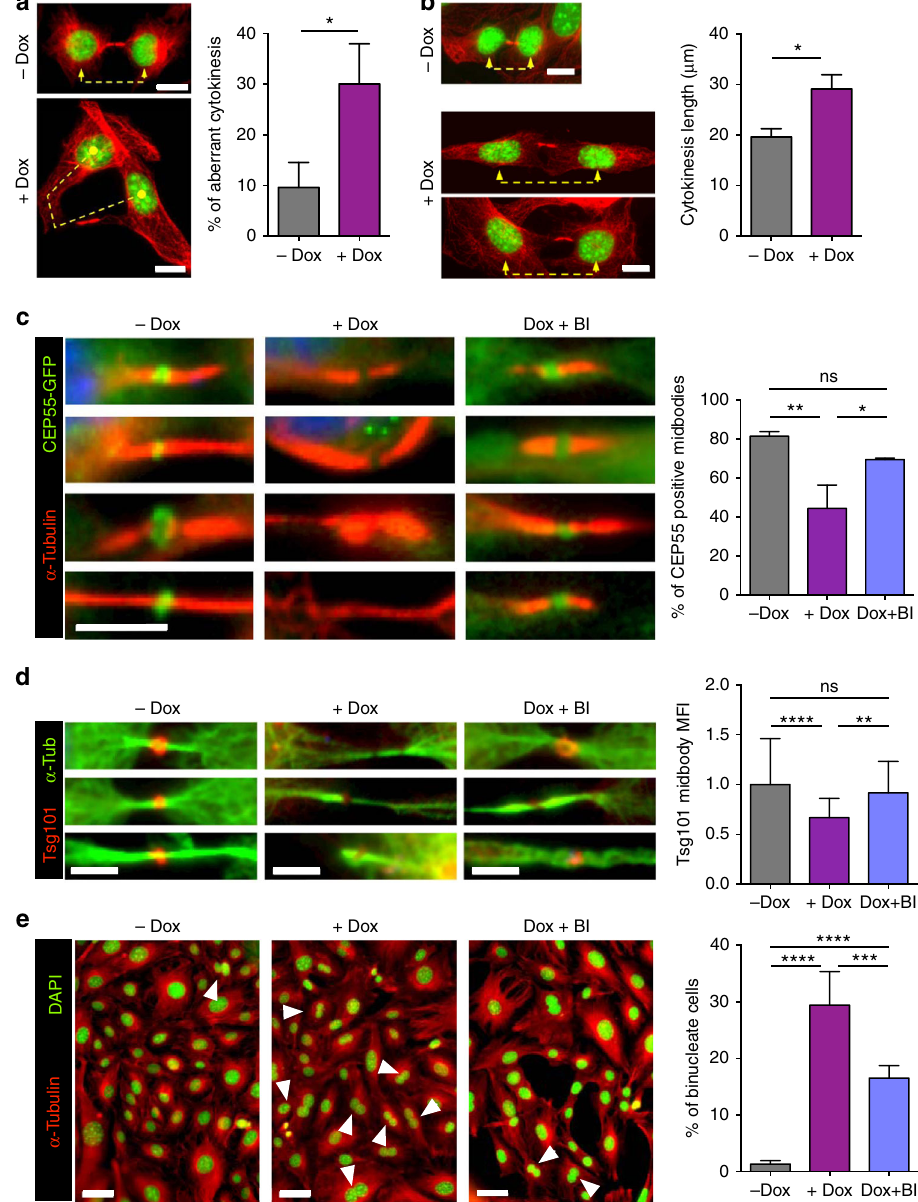
Fig. 5 Overexpression of Plk1 impairs Cep55 and ESCRT loading into the cytokinesis midbody. a ( + /Plk1);(rtTA/rtTA) MEFs were untreated ( – Dox) or treated for 24 h with doxycycline ( + Dox), fi xed and stained for α -tubulin (red) and DAPI (DNA, green). Cells in cytokinesis ( n > 100 per condition; n = 3 replicates) were evaluated for aberrant cytokinesis, considering the midbody formation and shape, and correct distribution of DNA into the two daughter cells. Scale bars, 10 μ m. b The length of the cytokinesis bridge was evaluated by measuring the distance in between the two daughter nuclei in MEFs untreated or after 24 h of Dox treatment ( – Dox, n = 17 cells; + Dox, 23 cells). Scale bars, 10 μ m. In a , b *, p < 0.05; Student ’ s t -test. c MEFs expressing a CEP55-EGFP fusion (green) were treated for 24 h with Dox ( + Dox), in the absence or presence of 1 μ M of the Plk1 inhibitor BI2536 for 1 h at the end of the Dox time (Dox + BI), or left untreated as control ( – Dox). α -tubulin is in red. Data represent the percentage of cells with positive CEP55-EGFP signal at the midbody ( – Dox, n = 134; + Dox, n = 94; Dox + BI, n = 47 cells; n = 3 replicates ( – Dox, + Dox) or 2 replicates (Dox + BI)). Scale bar, 5 μ m. d MEFs expressing a Tsg101-mCherry fusion (red) were treated for 24 h with Dox ( + Dox), in the absence or presence of 1 μ M of BI2536 for 1 h at the end of the Dox time (Dox + BI), or left untreated as control ( – Dox). α -tubulin is in green. Data represent Tsg101-mCherry mean intensity at the midbody ( – Dox, n = 81; + Dox, n = 60; Dox + BI, n = 37 cells; n = 2 replicates). Scale bars, 5 μ m. e MEFs were treated for 24 h with Dox ( + Dox), in the absence or presence of 1 μ M of BI2536 for 1 h at the end of the Dox time (Dox + BI), or left untreated ( – Dox). Cells were stained for α -tubulin (red) and DAPI (DNA, green) and binucleation index was quanti fi ed from more than 600 cells in each sample ( n = 5 replicates). Scale bars, 50 μ m. In c – e , n.s. not signi fi cant; * p < 0.05; ** p